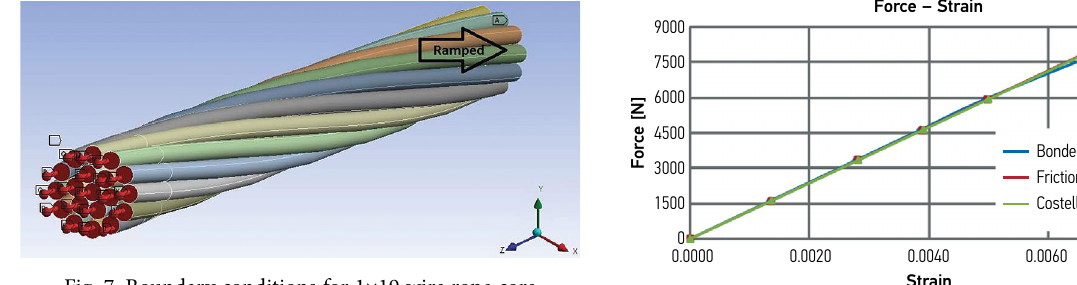
Fig. 8. Diagram of resulting axial strain for 1 × 19 wire rope core